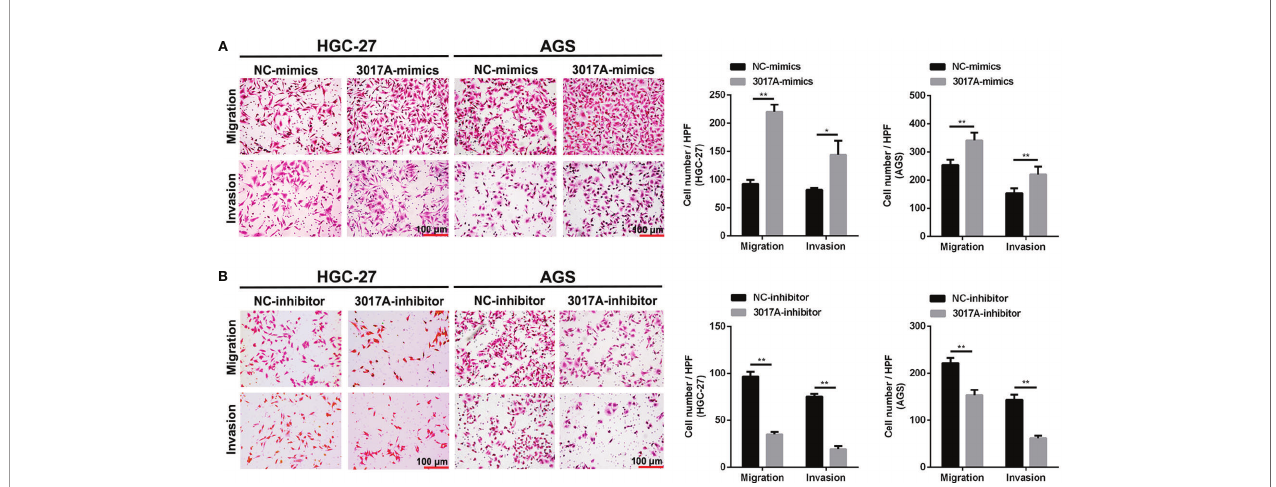
FIGURE 2 | Transwell assays veri fi ed the effect of tRF-3017A on migration and invasion of GC cells. (A) Migration and invasion of GC cell lines HGC-27 and AGS were investigated after tRF-3017A-mimics or NC-mimics. (B) Migration and invasion of GC cell lines HGC-27 and AGS were investigated after tRF-3017A-inhibitor or NC-inhibitor. Representative images and bar graphs were depicted. Data are shown as mean ± SD. NC, negative control. *P < 0.05; **P <